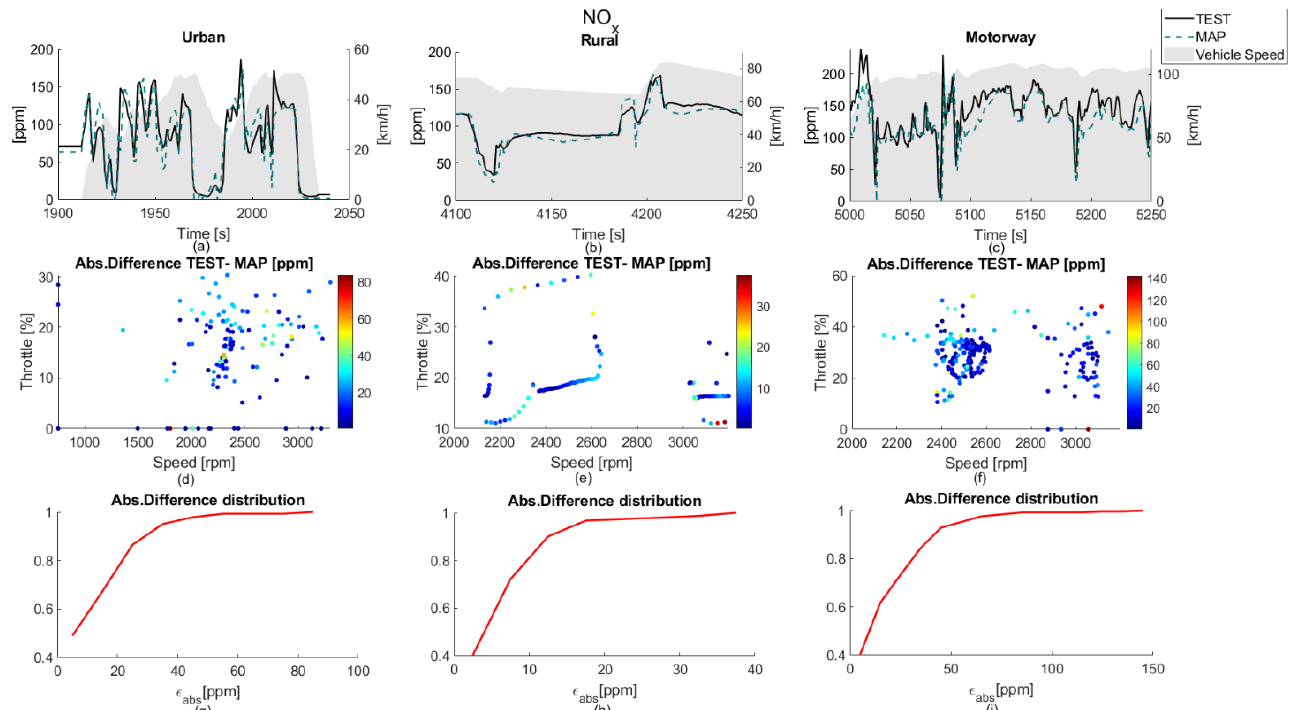
Figure 13. CO 2 emissions comparison between RDE 1 and engine map in urban ( a,d,g ), rural ( b , e , h ), and motorway ( c , f , i ) driving phases.